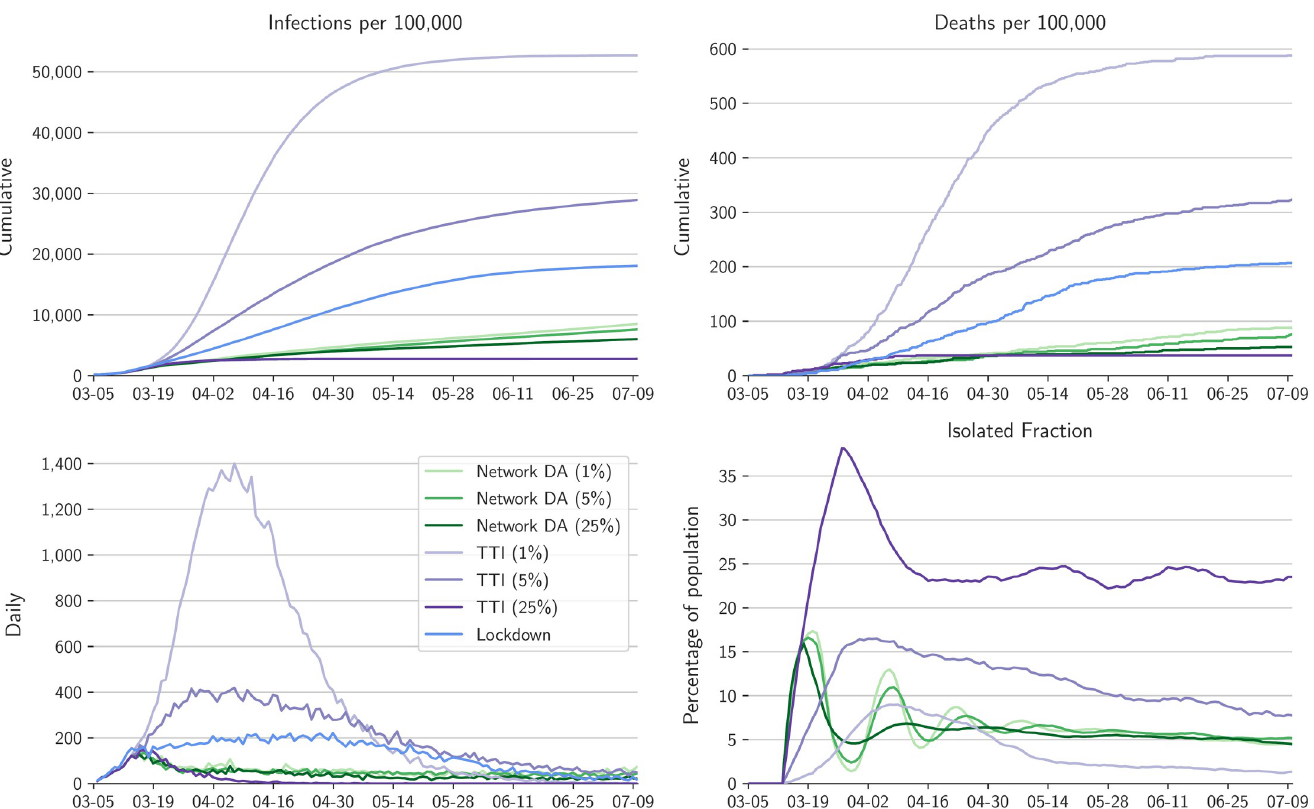
Fig 5. Comparison of different contact intervention scenarios for a user base with ~ N = N ¼ 75% . Plotting conventions as in Fig 4. TTI here is confined to the same user base as network DA, implying 75% compliance.